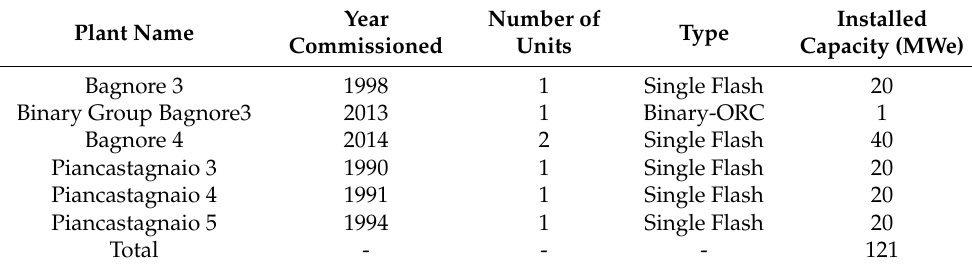
Table 3. Geothermal power plants (GPPs) in the Mt. Amiata region [13].